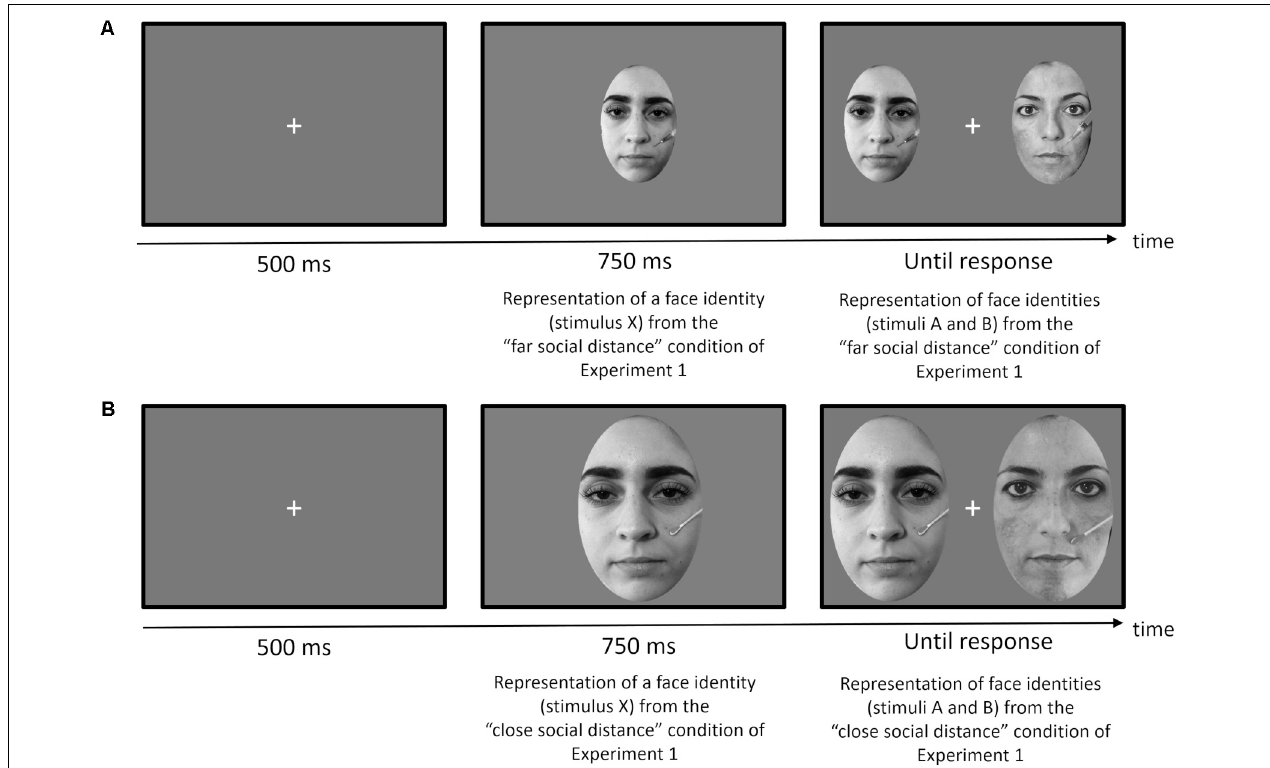
FIGURE 4 | Timeline of each trial for Experiment 2 (match-to-sample task): (A) example of a trial with faces used for the “far social distance” condition of Experiment 1; (B) example of a trial with faces used for the “close social distance” condition of Experiment 1. Original face stimuli have been replaced in (A,B) with actors according to the terms of use of the Eberhardt Lab Face